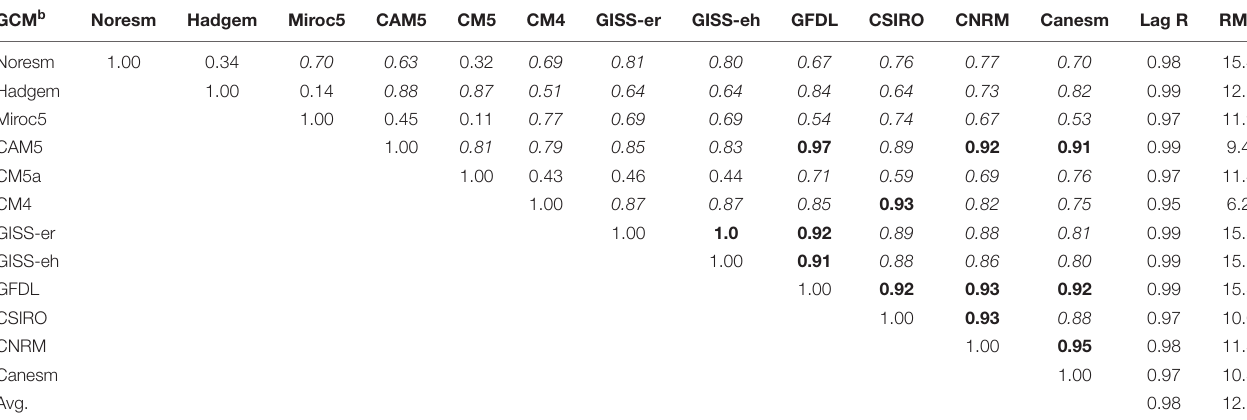
TABLE 1 | Student-t correlation matrix, Lag-1 R values, and RMS uncertainty of CMIP5 Model TCF a error residuals. GCM